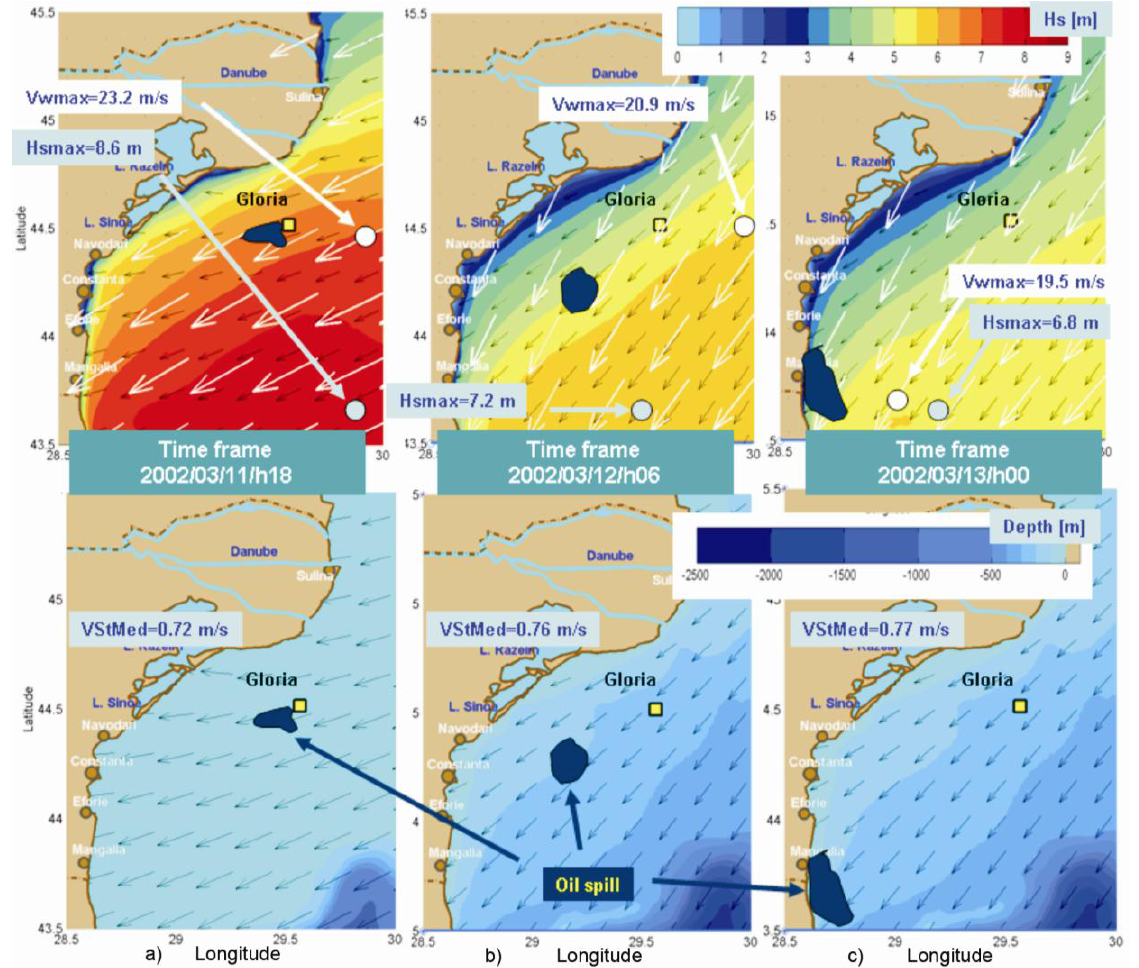
Fig. 2. Wave, wind and Stokes drift driving the oil spill towards the Romanian coast: a) time frame 2002/03/11/h18 (peak of the storm considered the zero moment of the hypothetic accident); b) time frame 2002/03/12/h06; c) time frame